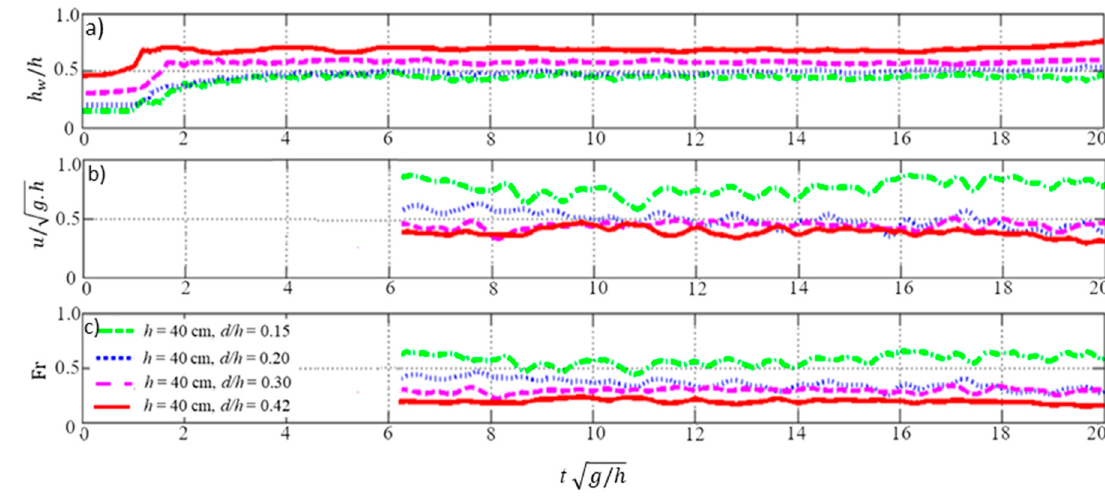
Figure 4. Wet bed bore characteristics at x = 6.5 for h = 40 cm, where different line types correspond to different d/h values: ( a ) water surface profile at WG3, ( b ) flow velocity, and ( c ) Froude number.